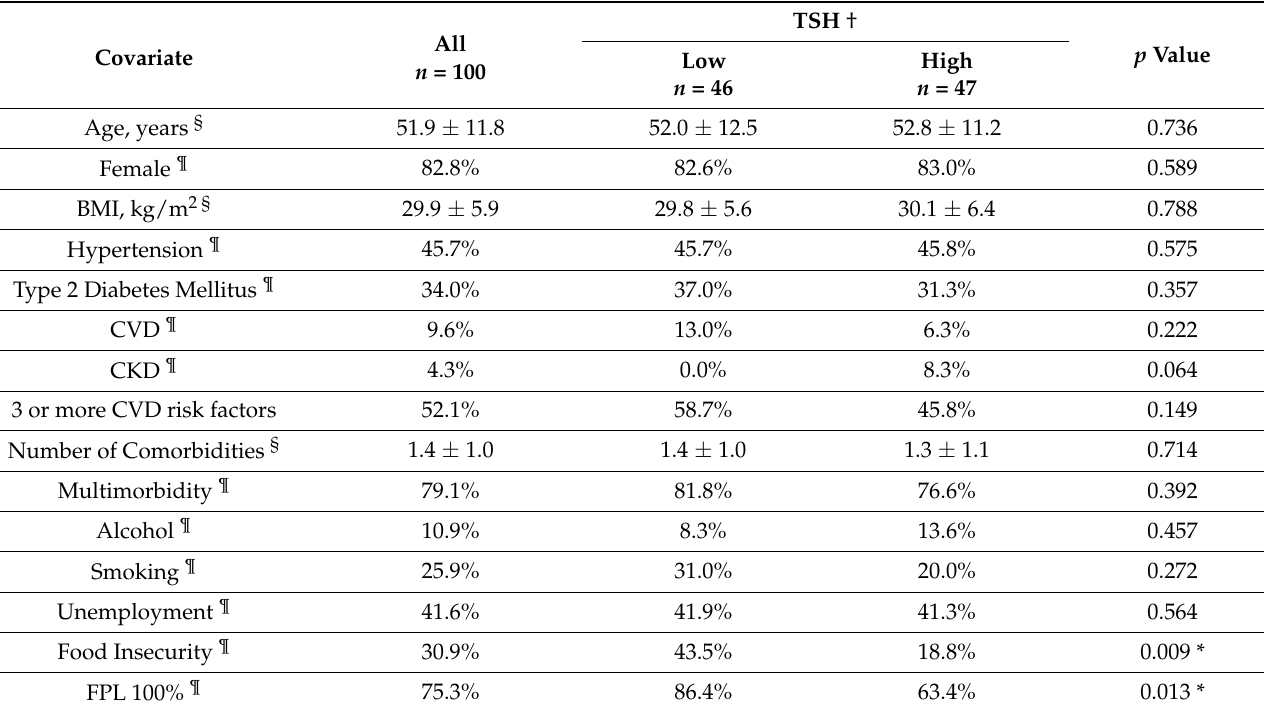
Table 1. Characteristics of the study patients by TSH